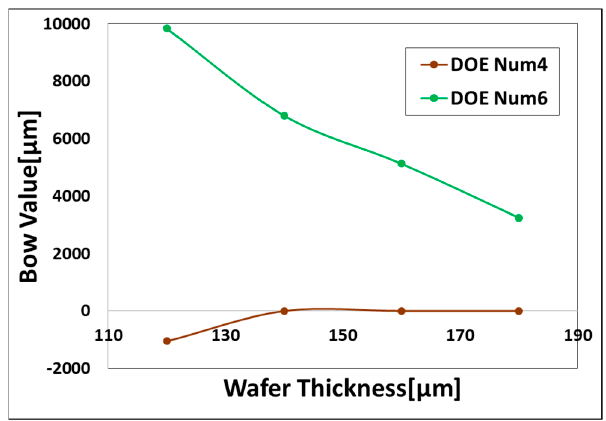
Figure 6. Results of bow experiments 4 and 6.